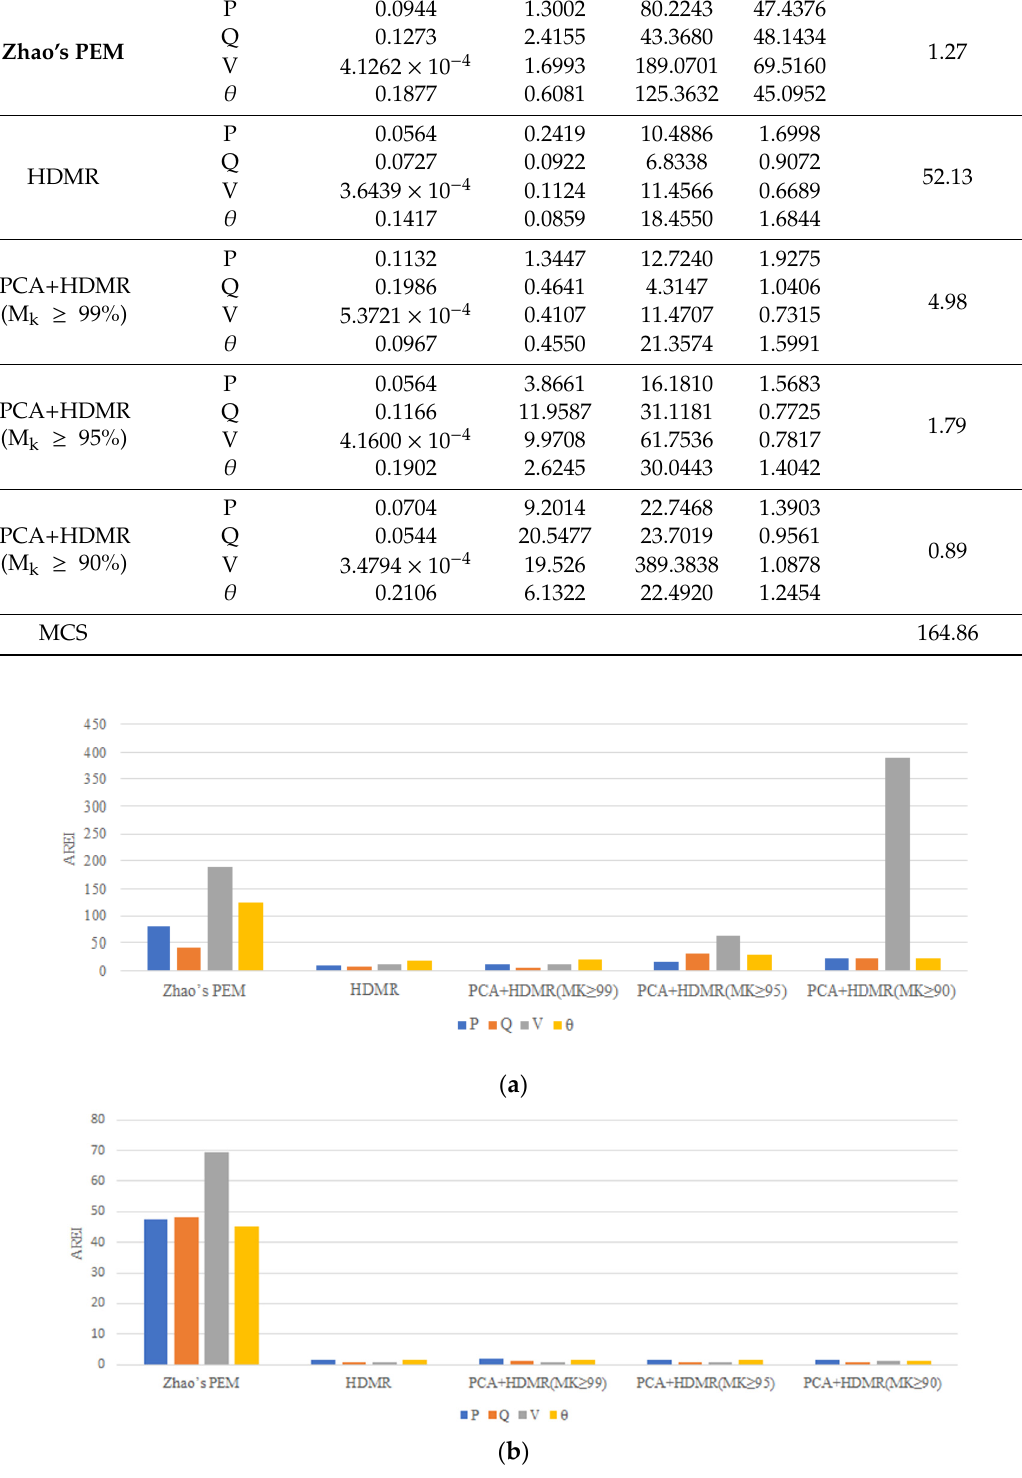
Table 3. Performance of evaluated methods (IEEE-30).